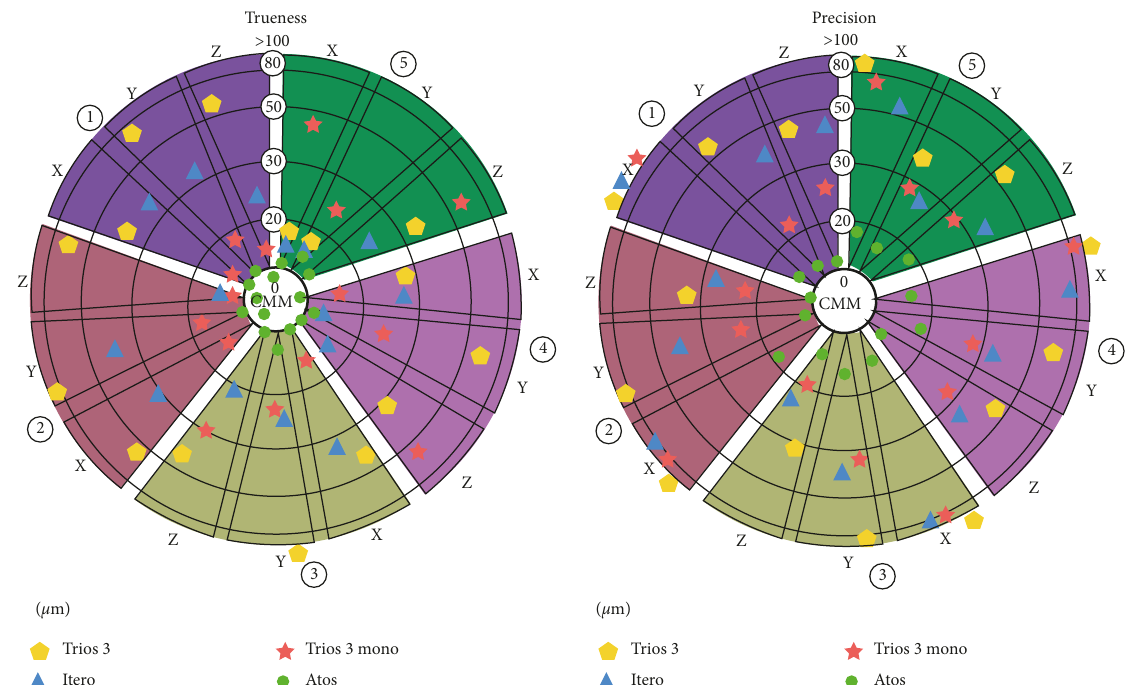
Figure 5: Bull’s eyes chart showing the deviations between the mean of repeated measurements for all implant axes of all scanner devices and the true values (trueness) and the deviations between the results of independent measurements obtained within one scanner device under specific condition (precision). This chart is color-coded; each color represents the implant number (1–5) in the master model. μ m